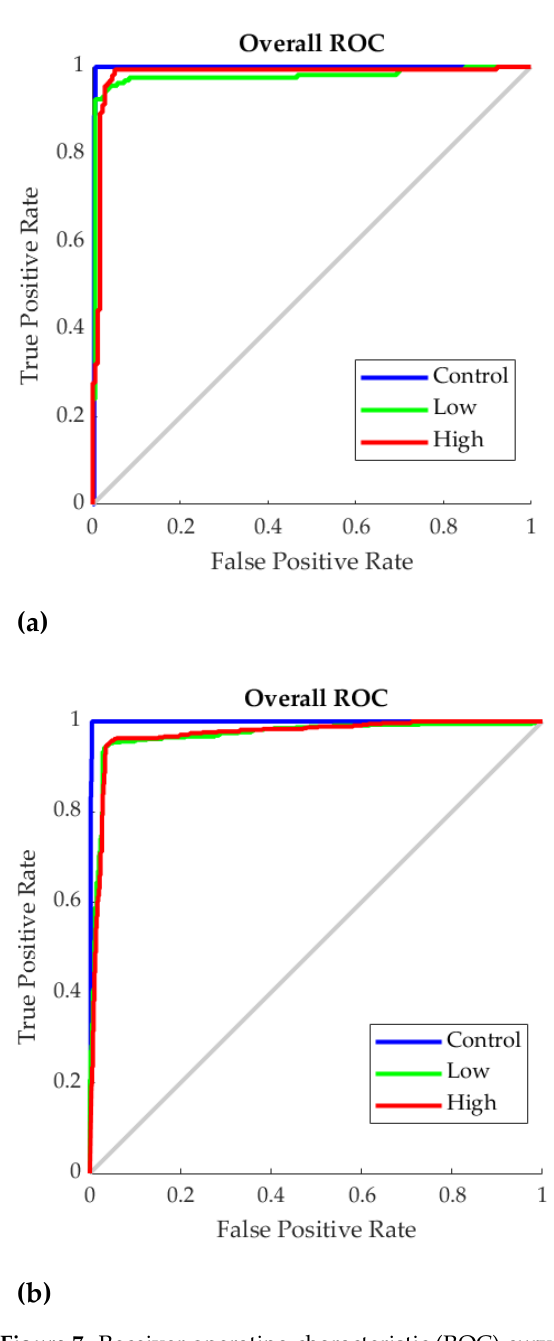
Figure 7. Receiver operating characteristic (ROC) curves of the models developed using ( a ) near- infrared (Model 1) and ( b ) electronic nose (Model 2) values as inputs to classify beers according to the concentration of faults present in them (control, low and high concentration).